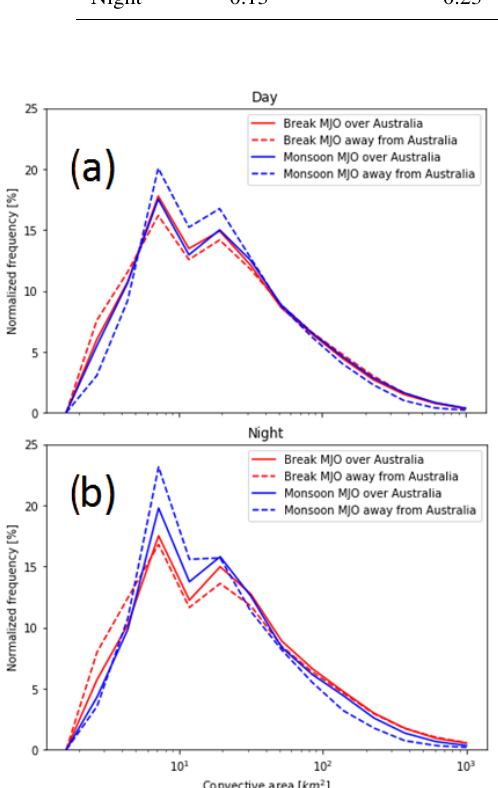
Figure 9. (a) normalized frequency distribution of convective areas during the day (06:00 to 19:00LT). Each curve represents the large- scale forcing specified in the legend. (b) as in (a) , but for